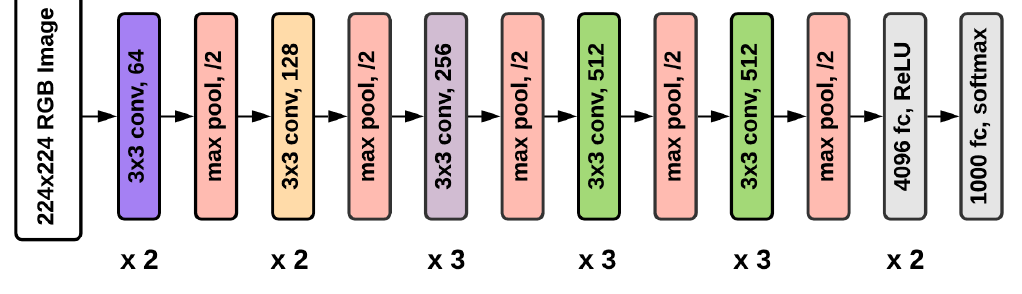
Figure 4. Architecture of VGG16